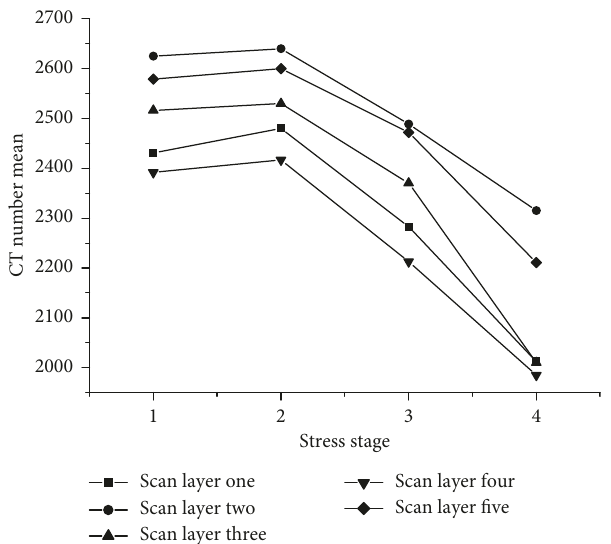
Figure 13: The curves of CTnumbers for the four stress stages for specimen CON073.